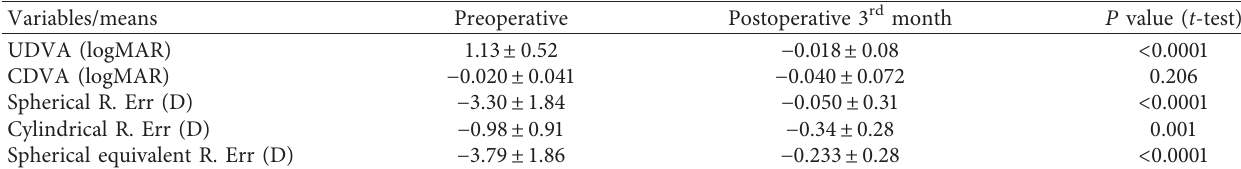
Table 1: Patient characteristics.